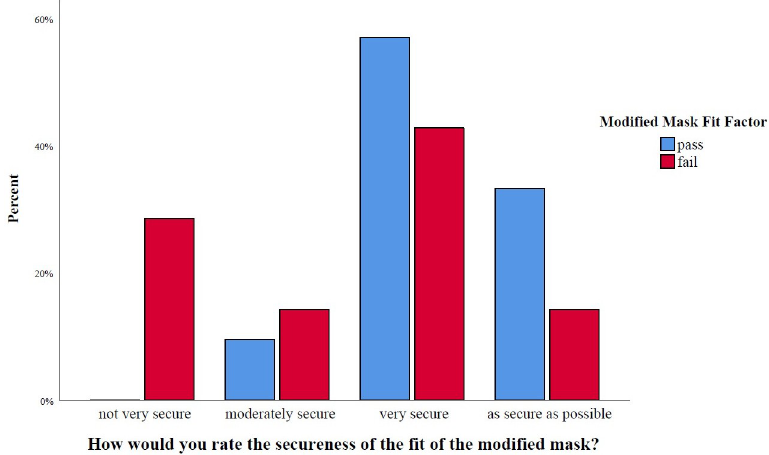
Fig 5. Subjective secure fit of the modified mask compared to the surgical mask stratified by outcome.